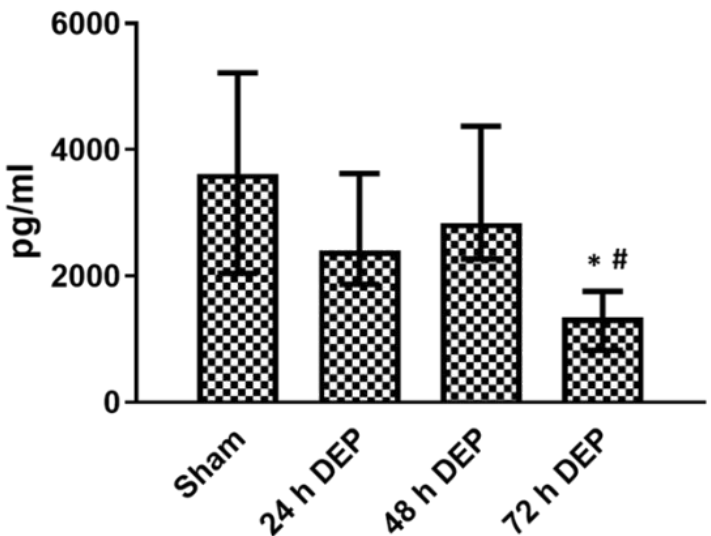
Figure 5. Release of MMP9 in basal medium following repeated exposure to diesel exhaust particles (DEP: 12.7 µ g/cm 2 ). Concentration of MMP9 in bronchial mucosa models developed at air–liquid interface (bro-ALI) following incubation for 24 hours (h) after 3 min exposure to sham (control: clean air exposure) and DEP for 3 time points (24, 48 and 72 h). Data presented as median and 25th – 75th percentiles (N = 3 donors and n = 2 replicates/donor). p < 0.05 *: significant compared to sham, #: significant compared to exposed at 24 h.